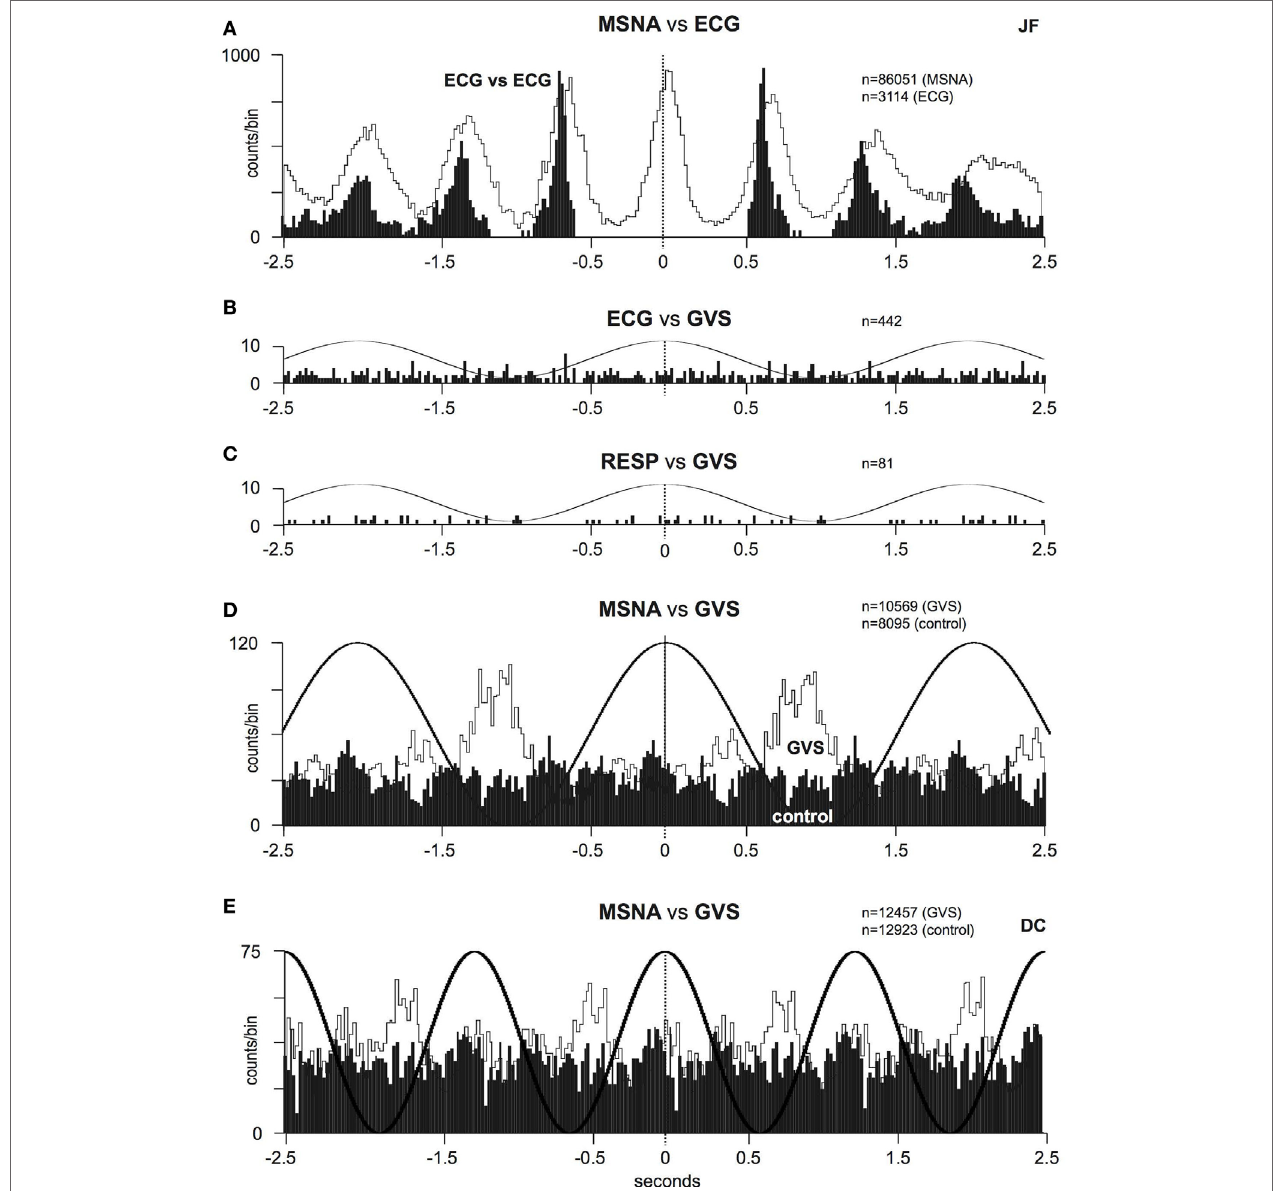
FiGURe 3 | (A) Cross-correlation histograms of the relationship between muscle sympathetic nerve activity (MSNA) and R-waves of the ECG (white histogram) and autocorrelogram of the ECG (black histogram). (B,C) Cross-correlation histograms between ECG and sinusoidal GVS (sGVS) and respiration (inspiratory peaks) and sGVS. A 0.5 Hz sine wave has been superimposed on the histogram to illustrate the timing of the galvanic vestibular stimulation; it has been inverted for clarity. (D,e) Cross-correlation histograms of MSNA with respect to the vestibular input (GVS), in white, or to a control sine wave (control), in black. Data in panels (A–D) are from the same subject represented in Figure 1 ; data in panel (e) were obtained from another subject. 20 ms bins in all panels. n = the numbers of counts comprising the histograms. Reproduced with permission from Bent et al.